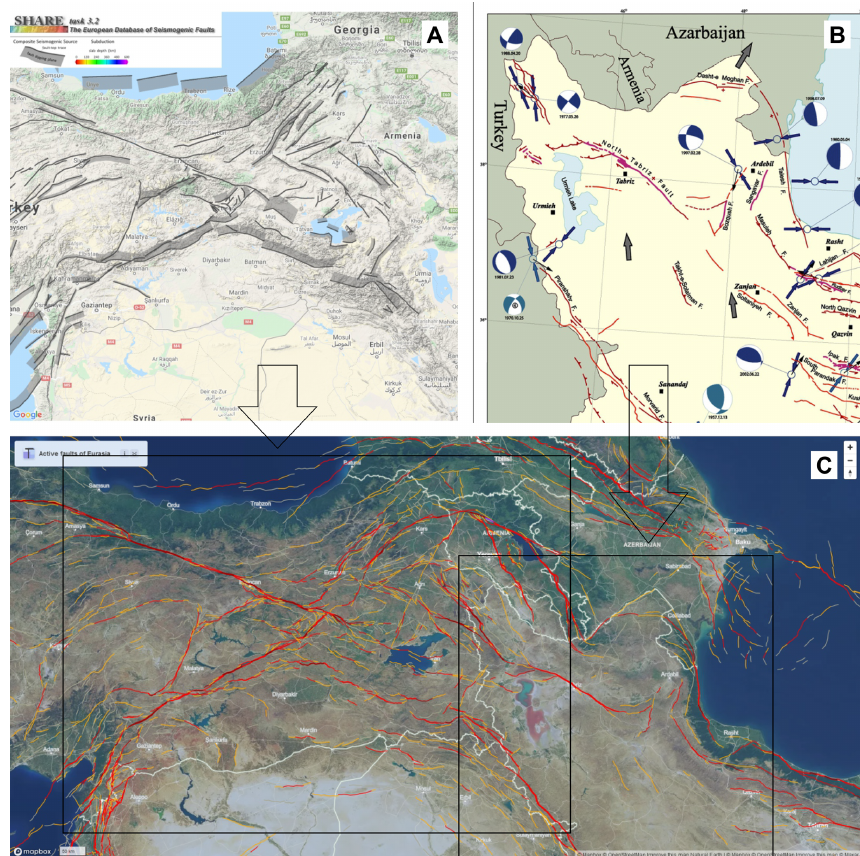
Figure 4. Active faults in Transcaucasia, showing (a) the web interface of the European database of Seismogenic Faults (Basili et al., 2013), (b) a fragment of the Major Active Faults of Iran Map (Hessami et al., 2003), and (c) the AFEAD web interface (http://neotec.ginras.ru/ index/mapbox/database_map.html, last access: 5 May 2022) for this